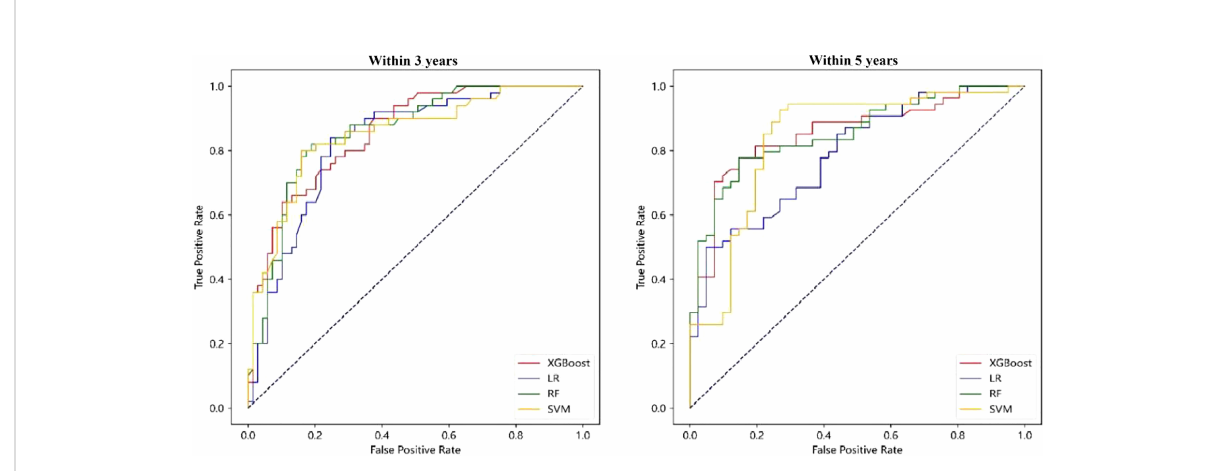
FIGURE 2 ROC curve of “ Chinese medicine intervention prognostic model ”